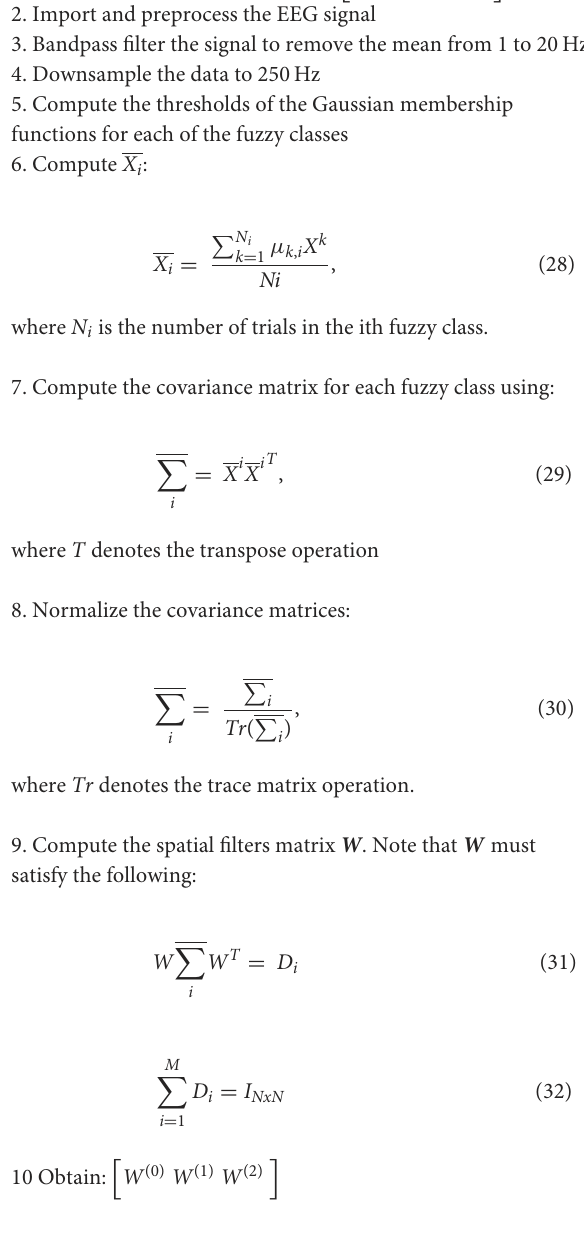
Algorithm 17. CSSP algorithm (Reddy et al., 2019).